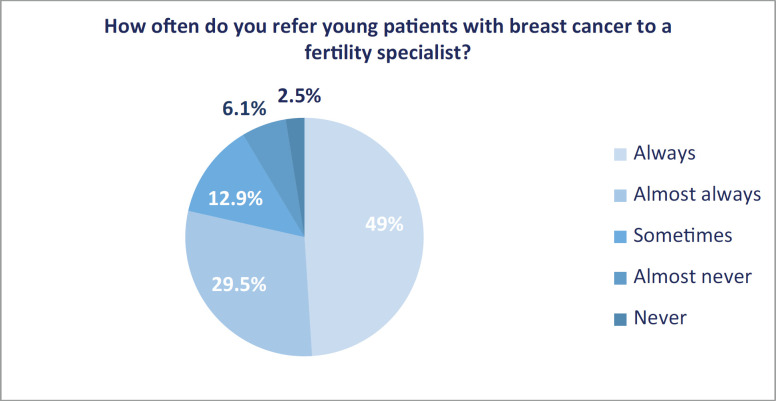
Frequency of referral to a fertility specialist.